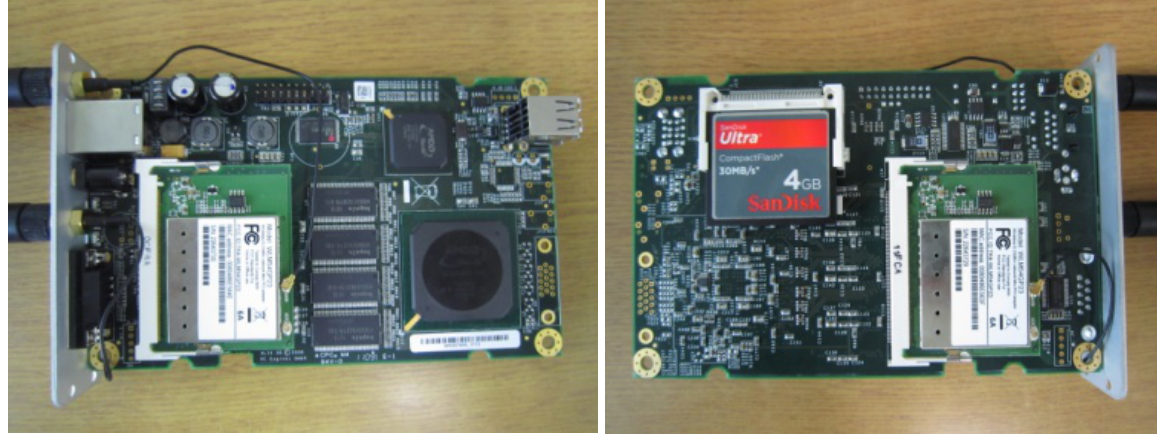
Figure 2. The (left photo) top view and (right photo) bottom view of the embedded